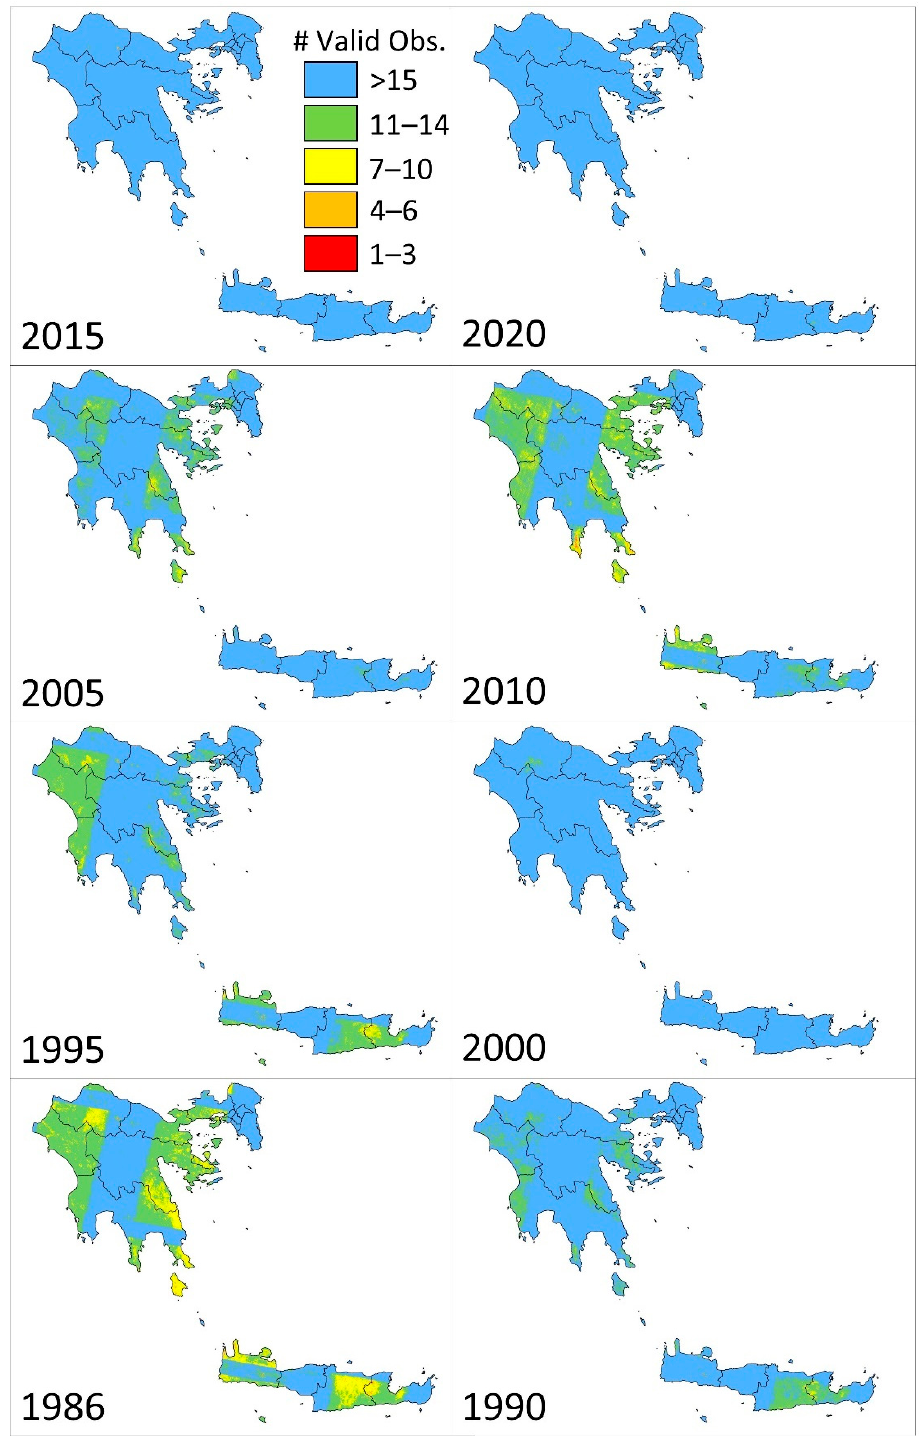
Figure 2. Total number of annual valid (cloud-free, shadow-free, snow-free) observations across the study area every ~five years throughout the time